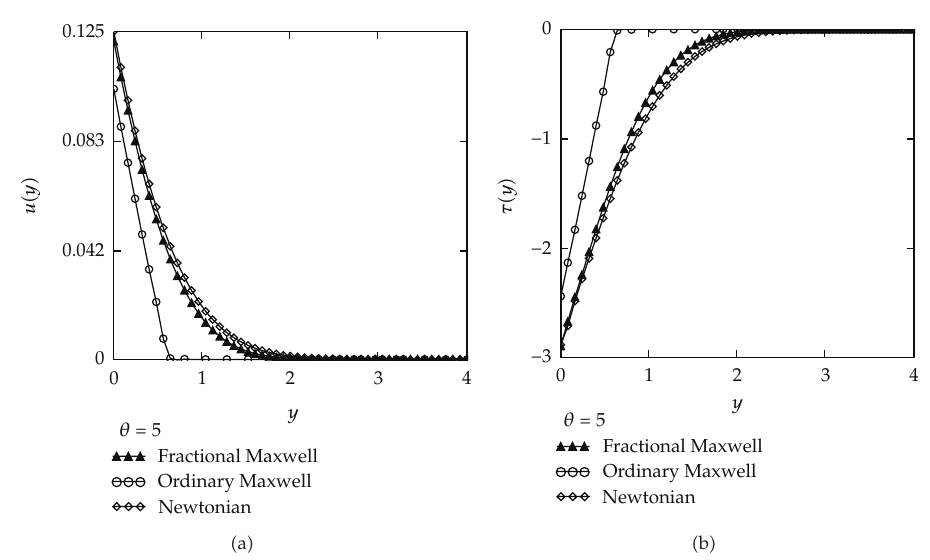
Figure 14: Profiles of the velocity field u (cid:4) y,t (cid:5) and the shear stress τ (cid:4) y,t (cid:5) for fractional Maxwell, ordinary Maxwell and Newtonian fluids, for U (cid:9) 1, y (cid:9) 1, ν (cid:9) 0 . 379, μ (cid:9) 33, λ (cid:9) 1 . 5, α (cid:9) 0 . 2, t (cid:9) 2s, and θ (cid:9) 5 .